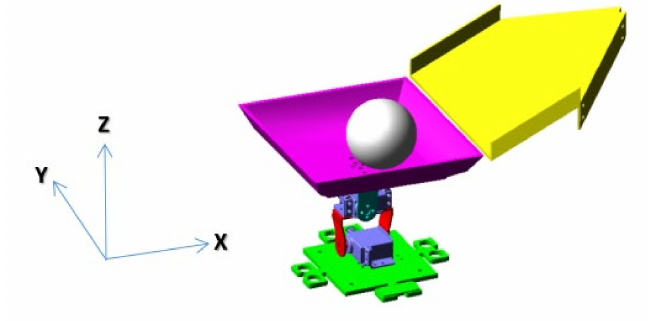
Figure 13. Coordinate system of the